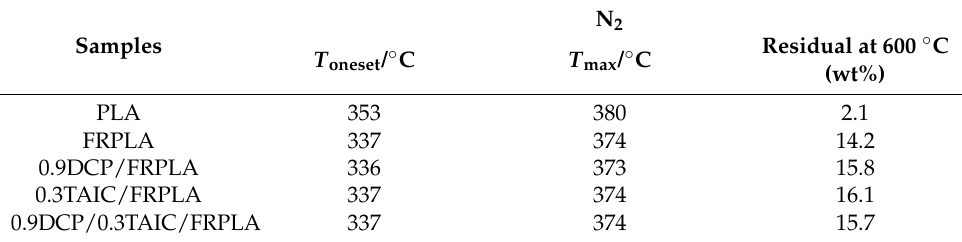
Figure 7. The curves of thermal performance: ( a ) TG curves; ( b ) DTG curves; ( c ) the crystallization curves of the heating process; ( d ) the crystallization curves of the cooling process. Table 3. The data of TG and DTG for PLA and PLA composites under N 2